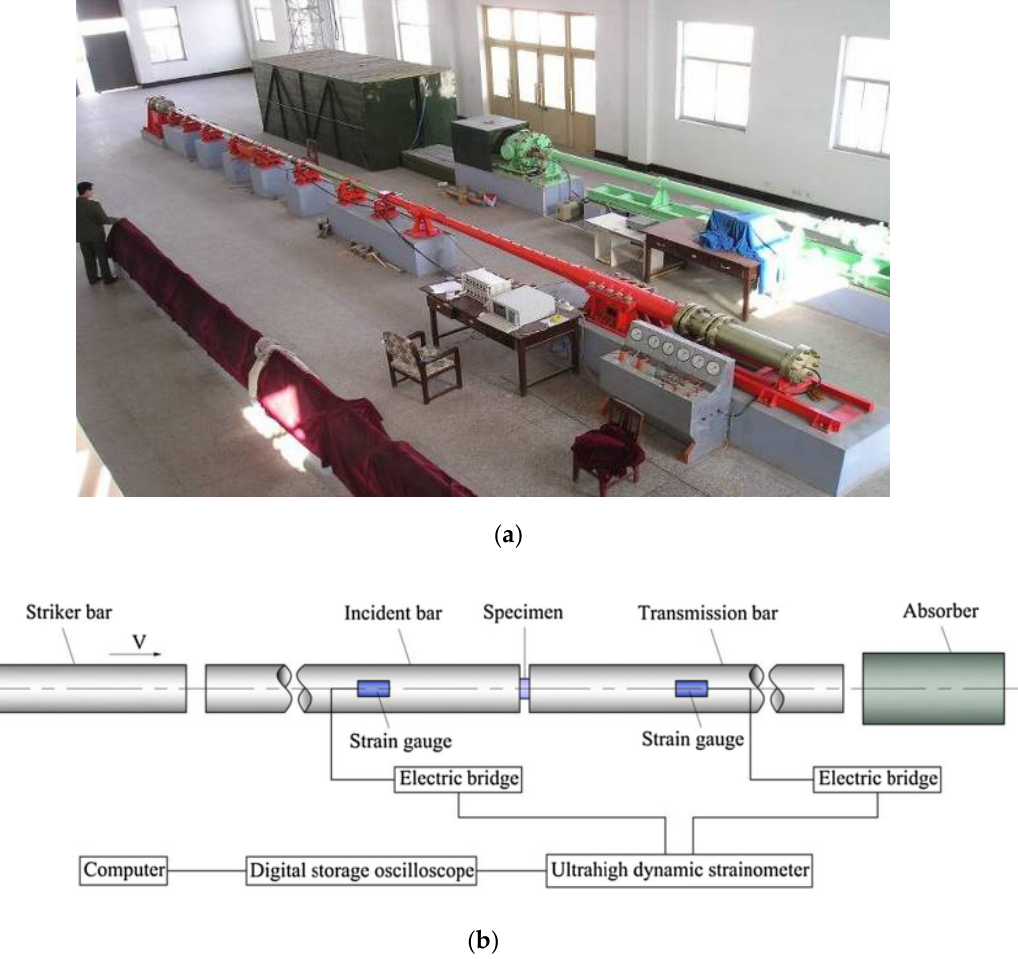
Figure 2. An SHPB device separated by 100 mm. ( a ) Physical map of the SHPB device. ( b ) Schematic diagram of the SHPB device.